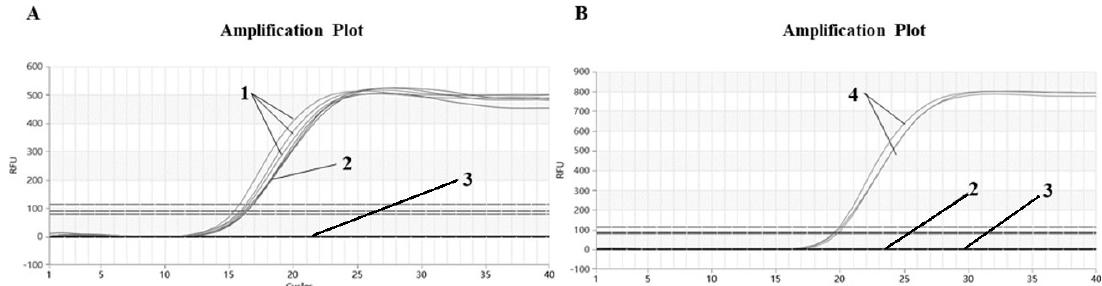
Figure 5. Proofman–LMTIA method for testing Ama’s pure cow milk in Qinghai–Tibet Plateau. ( A ): Verification of cow milk DNA: 1: beef gDNA; 2: cow milk DNA; 3: ddH 2 0; ( B ): Detection of soybean-